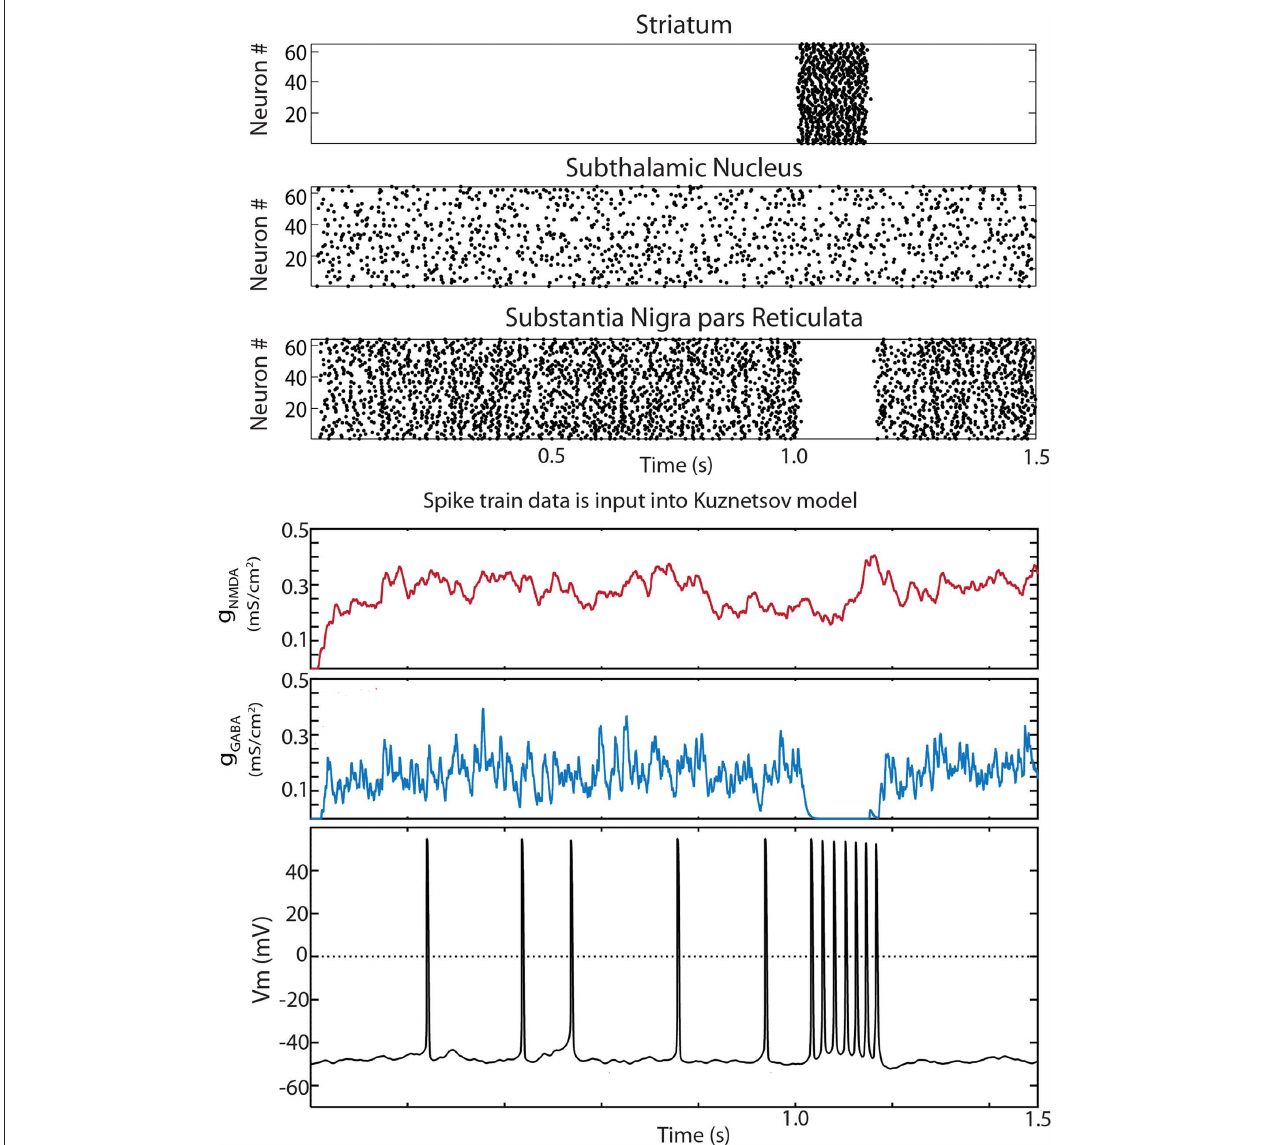
10 s. The input to a random SNpc neuron was captured, saved to a file, and read in by the modified Kuznetsov et al. (2006) model. The synaptic conductances and resulting trace are shown below. Conductances were initially set at zero. The dopaminergic neuron model fired single spikes at approximately 5 Hz and exhibited a burst of action potentials during the period of